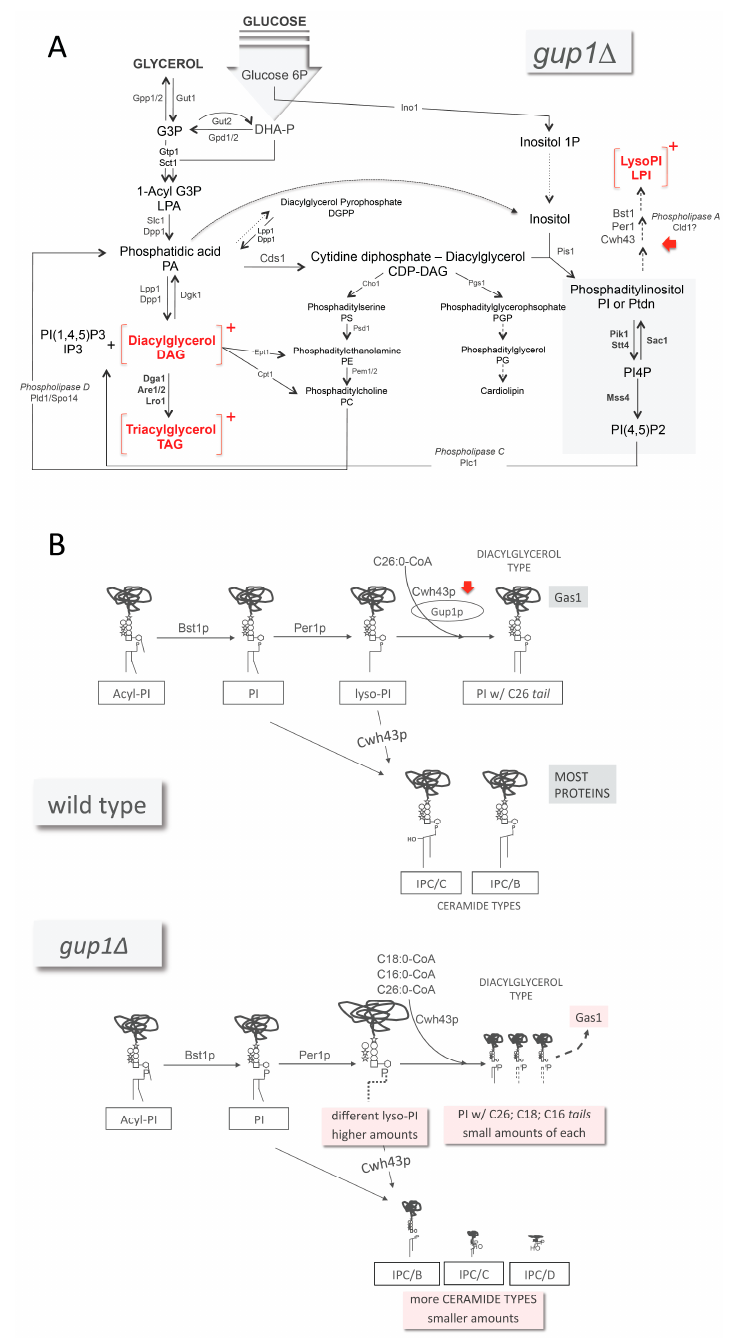
Figure 3. ( A ) Key lipid synthesis pathways from S. cerevisiae . In red are shown the types of lipids which amounts are affected by the GUP1 deletion. Steps in GPI anchor synthesis occurring in S. cerevisiae wild-type strain ( B ) and in gup1 ∆ mutant (C). Gas1 is an example of a GPI anchored protein that is found excessively liberated into the medium in the mutant cultures. Red arrows indicate the step in which Bosson et al. (2006) suggest that Gup1 acts as an acyltransferase. GPI anchor backbone is composed of mannose ( ), glucosamine ( ) and ethanolamine-P ( ). Dark thick scrawls represent peptide chains. PI: phosphatidylinositol; IPC: inositol phosphoceramide. Types B, C and D were defined from bands obtained using TLC [136].